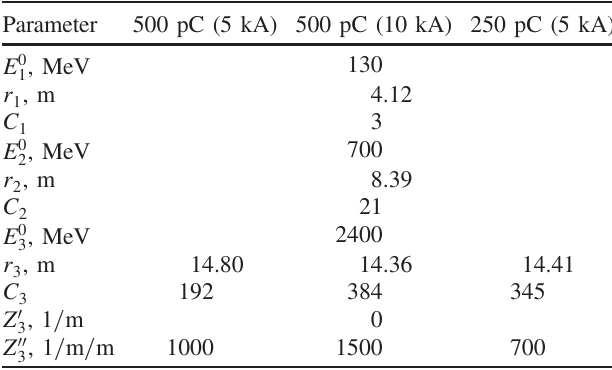
TABLE V. The longitudinal dynamics